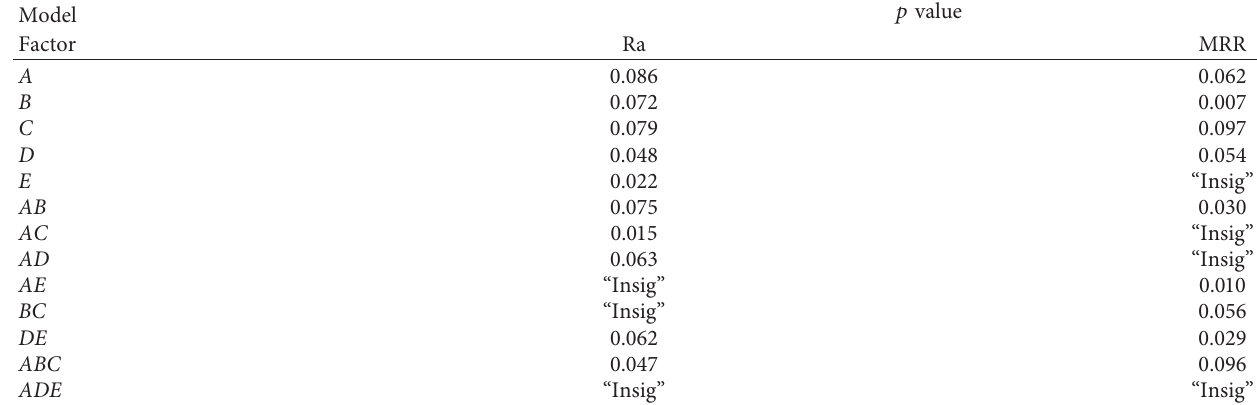
Table 7: Major factors and corresponding p values for PMEDM